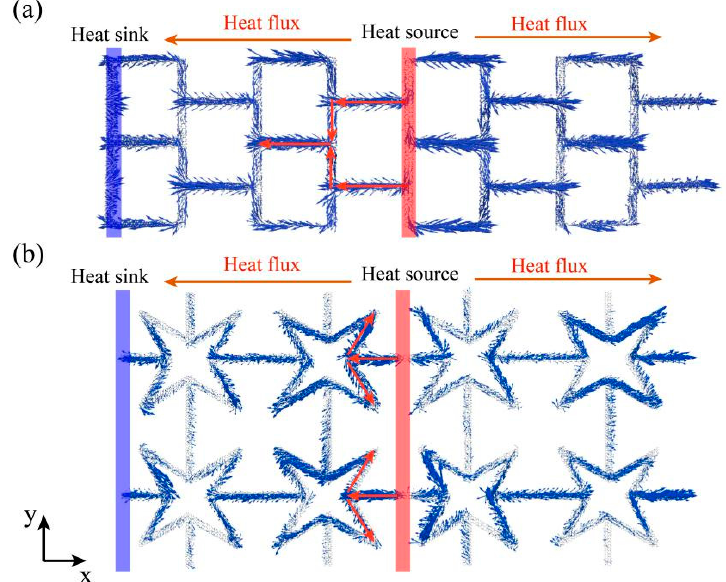
Figure 7. Spatial distribution of heat flux by vector arrows on each atom in SKG ( a ) and QSS ( b ) under the non-equilibrium steady state. The global heat flux transport directions are labeled with red rows with the heat source and heat sink are located at the middle and both ends of the model.